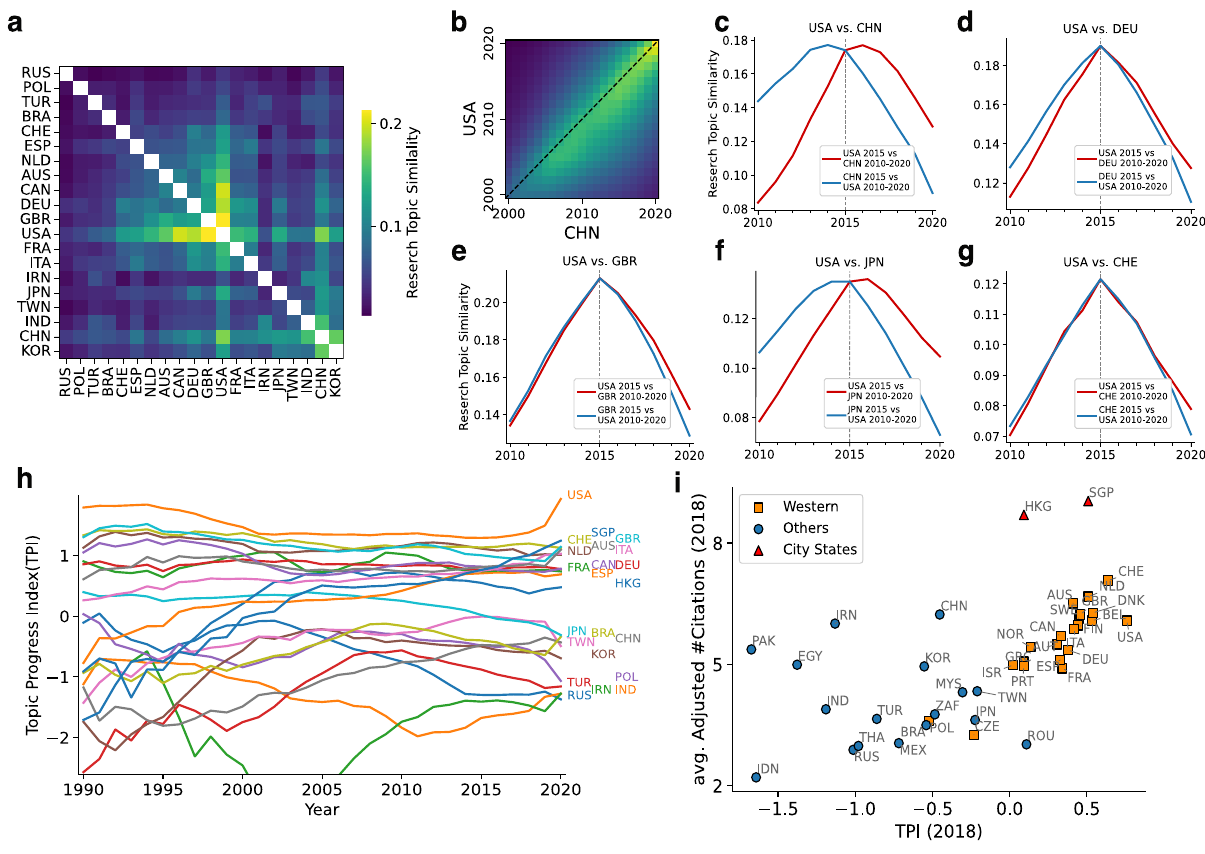
Figure 1. ( a ) Cosine similarity of research topic T in 2015 between the top 20 paper-publishing nations. The order of the nations is determined by average linkage clustering. ( b ) The cosine similarity matrix of T between China and the US from 2000 to 2020. ( c – g ) Two-nation comparisons: red lines indicate cosine similarities between T in 2015 in the US and T in 2010-2020 in China ( c ), Germany ( d ), the UK ( e ), Japan ( f ), and Switzerland ( g ). Blue lines indicate the opposite comparisons (in the other nation in 2015 and in the US in 2010- 2020). ( h ) Yearly change in the TPI of the top 20 paper-publishing nations, plus Hong Kong and Singapore, from 1990 to 2020. ( i ) The average domain-adjusted citation count versus the TPI, both in 2018 for the top 40 paper- publishing nations. The figures were generated using matplotlib(3.6.0) and labeled with